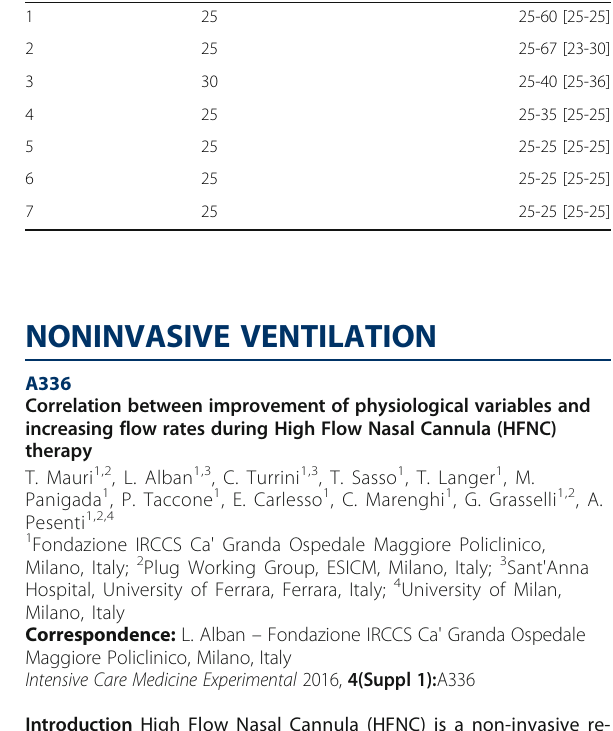
Table 106 (abstract A335). CRRT Prescription in First Week Day